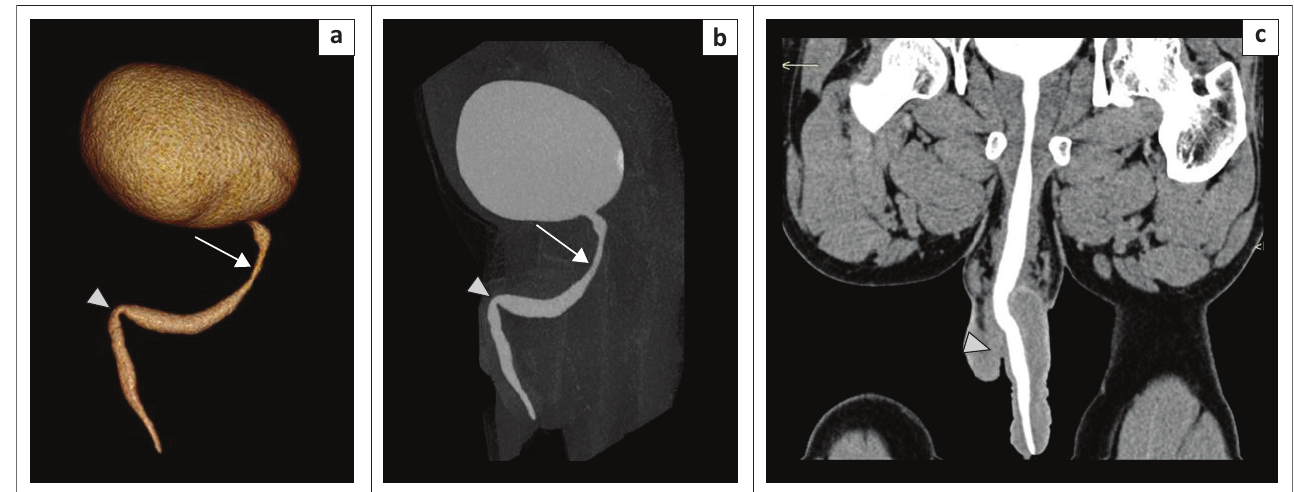
FIG URE 1: Multidetector computed tomographic urethrography (MDCTU) of a normal urethra: (a) volume rendering technique image in the sagittal view, (b) maximum intensity projection image in the sagittal view and (c) curved multiplanar reformatted (MPR) image. The urethra is seen arising from the bladder neck as a contrast- filled tubular structure and opening into the external urethral meatus. The membranous urethra is the narrowest part with near-parallel walls, at the level of the external urethral sphincter. The bulbar urethra is the widest portion having a normal coned appearance at the bulbomembranous junction (arrow). The bend or kink at the peno-scrotal junction (arrowhead) is normal since the penis is not stretched on MDCTU. The curved MPR image (c) confirms the kink as normal calibre.